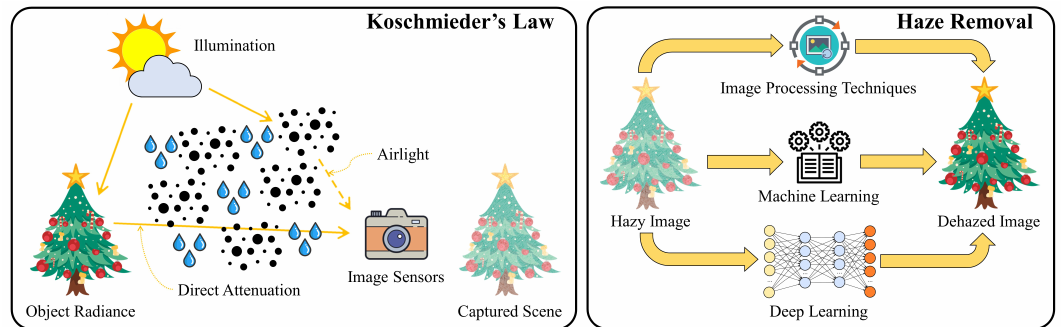
Figure 1. Visual illustrations of Koschmieder’s law and the three main categories of haze removal techniques.